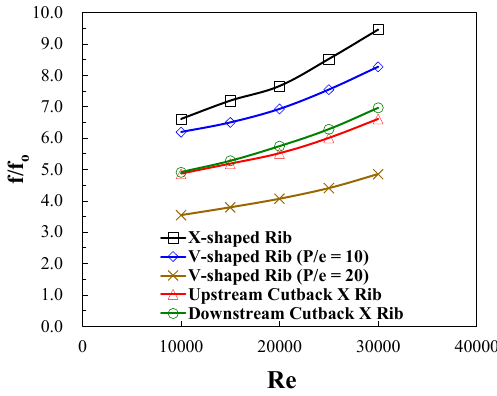
Figure 11. Friction factor ratios.